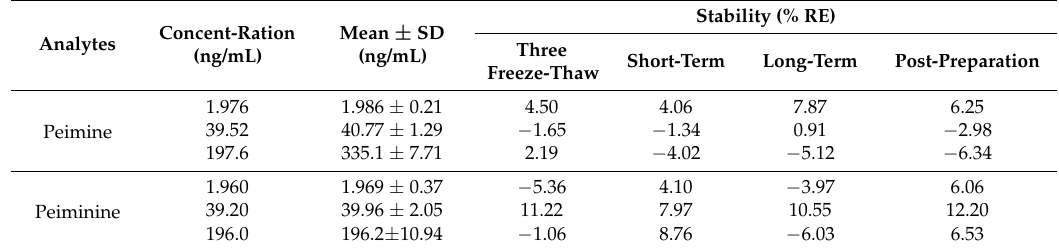
Table 5. Stabilities of peimine and peiminine in beagle plasma under various conditions ( n = 6).